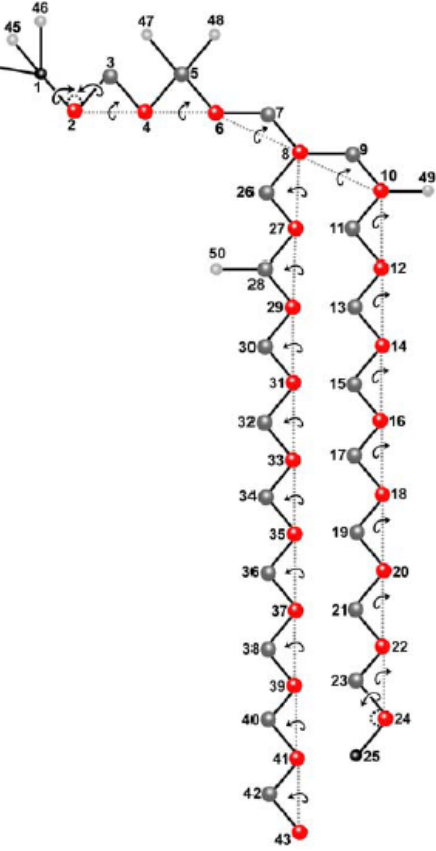
Figure 1. Molecular model of DPPC for atomistic Monte Carlo simulation. A united atom representation of dipalmitoylphosphatidylcholine (DPPC), which neglects hydrogen